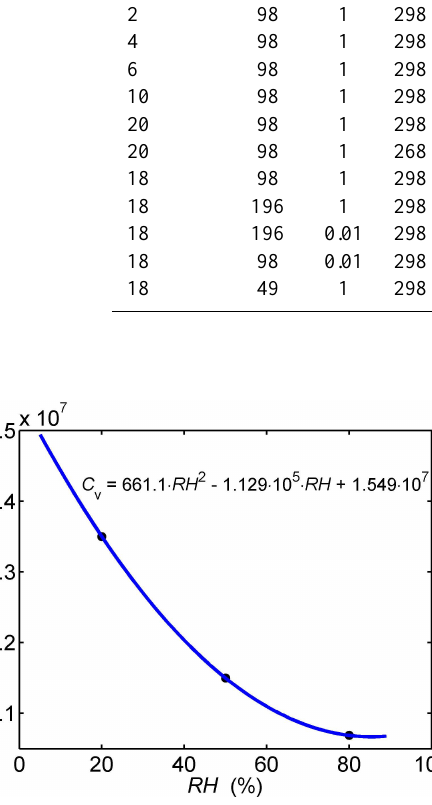
Fig. 5. Concentration of hydrated sulphuric acid required for growth rate 1nmh − 1 over size range 1.5–3nm as a function of relative hu- midity. Points represent the calculated sulphuric acid concentra- tions according to Eq. (8), when the relative humidity dependent hydration of sulphuric acid molecules has been taken into account. Solid line is a second order polynomial fit to the calculated points. In the fitting equation RH is given in